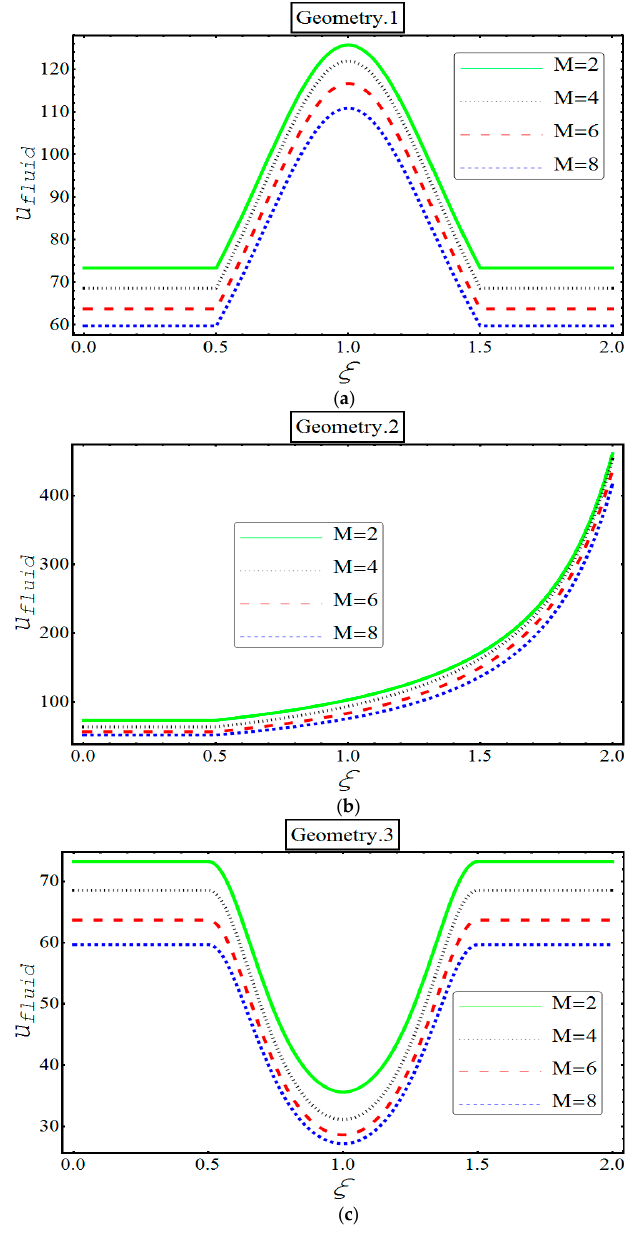
Figure 4. Variation of velocity (cid:1873) (cid:3033) for various Hartmann numbers. Figure 4. Variation of velocity u f for various Hartmann